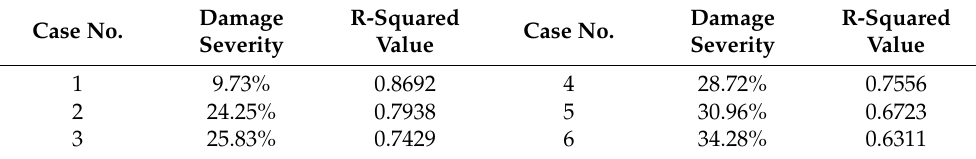
Table 3. Fitted damage severity 1 − ζ 1 and R-squared value. Case